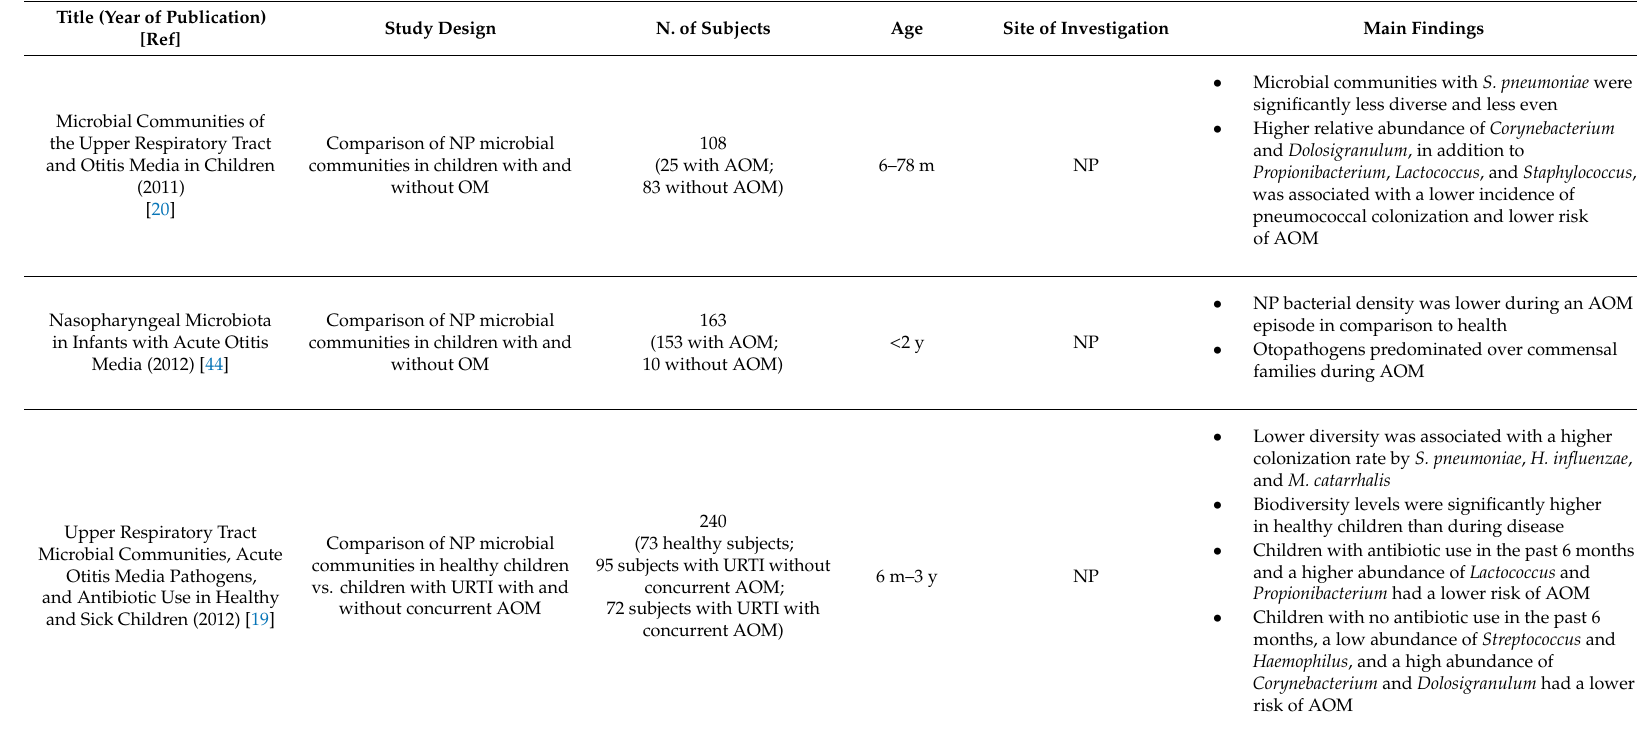
Table 2. Overview of investigations on microbiota and acute otitis media discussed in this